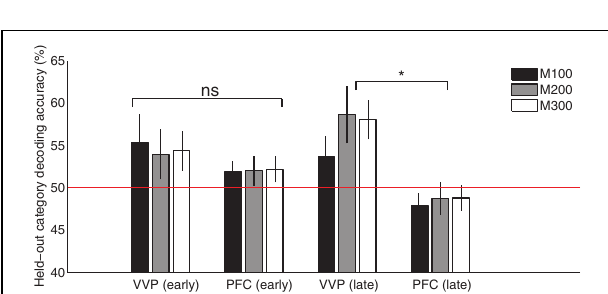
FIGURE 8 | Cortical category-predictive accuracies. Pooled held-out category predictive accuracies from ventral visual and prefrontal cortices based on the first and final 100 trials during M 100 (50–150ms), M 200 (150–250 ms) and M 300 (250–350 ms) after visual stimulus onset. Asterisk indicates significant difference ( p < 0 . 005) in predictive accuracy between VVC and PFC at M 200 and M